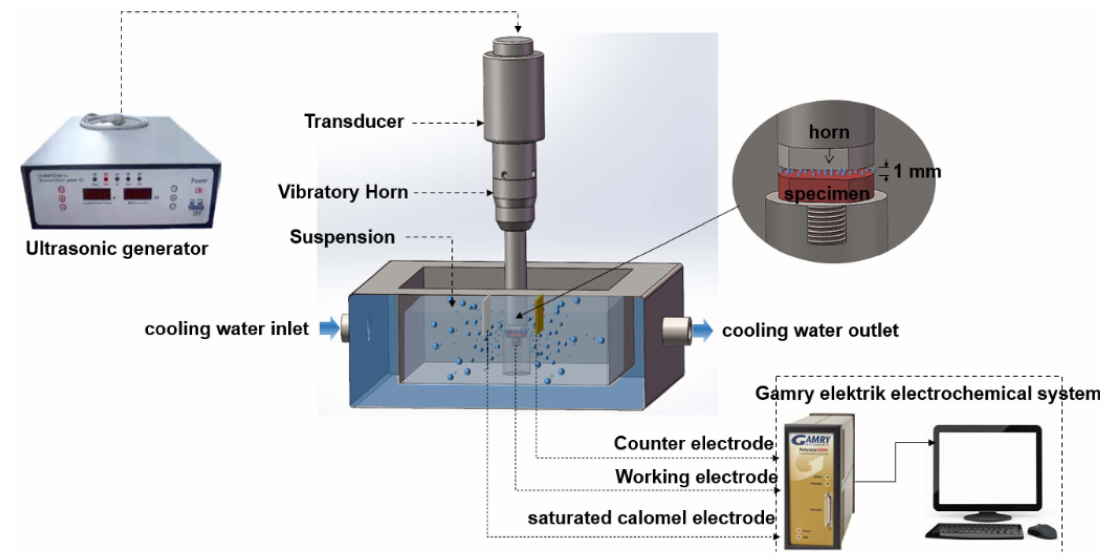
Figure 2. Schematic diagram of CE equipment with electrochemical test system.